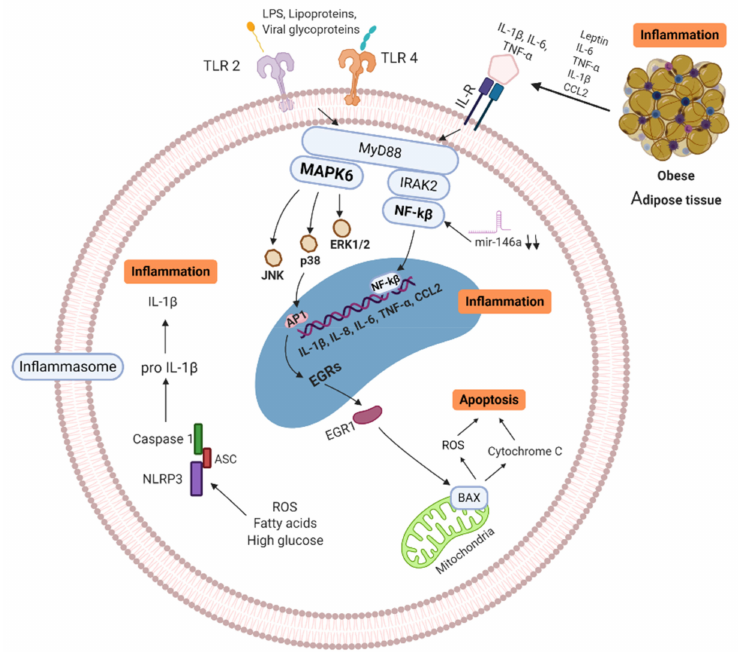
Figure 1. Signaling pathways of obese/T2D immune cell (MNC/MP). Senescence-associated se- cretory phenotype (SASP) cells secrete high quantity of pro-inflammatory cytokines, which trigger enhanced mitochondrial apoptosis through high mitogen-activated protein kinases (MAPKs). ROS production, free fatty acids and high glucose induce activation of NLRP3 inflammasome, activat- ing IL-1 β , leading to further inflammation. In addition, Pattern Recognition Receptors (PRR) and Interleukin Receptors (ILR) signaling through NF- κ B and MAPKs pathways, resulting in more in- flammatory cytokine production (IL-1 β , IL-6, IL-8, IL-18, CCL-2, and TNF- α ). Activation of these pathways increases the production of pro-inflammatory cytokines and promotes the infiltration of more pro-inflammatory M1 macrophages in tissues. MAPK: Mitogen-activated protein kinase, IL: Interleukins, ILR: Interleukins receptor, TNF: Tumor necrosis factor, BAX: BCL2-associated X genes, JNK: c-Jun N-terminal kinase, IRAK-2: Interleukin-1 receptor-associated kinase 2, EGRs: Early response genes, NF- κ B: nuclear factor kappa B, TLR: Toll-like receptor, CCL2: C-C motif chemokine ligand 2, ROS: Reactive oxygen species, mir146a: microRNA-146a, NLRP3: NLR family pyrin domain containing 3, ASC: Adaptor protein. Created with